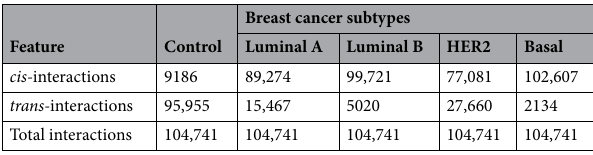
Table 1. Number of cis- and trans- gene–gene interactions in the five